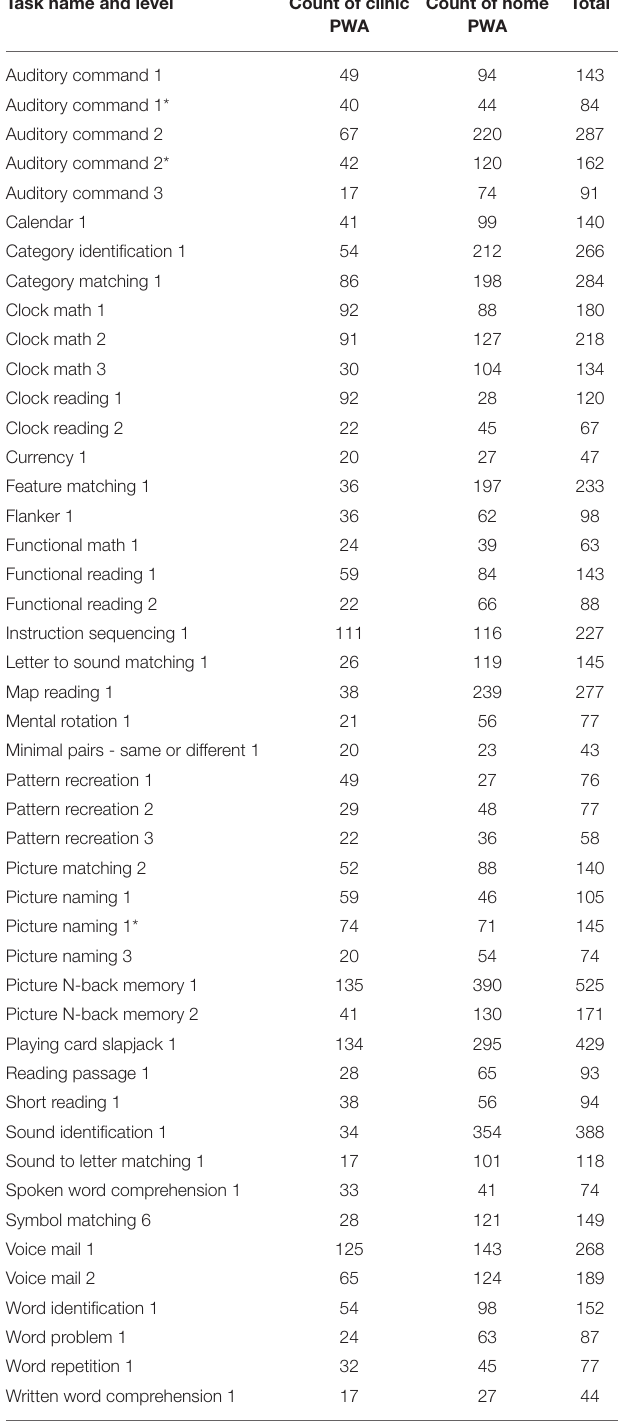
TABLE 1 | Count of PWA in age and years since injury bins, by home and clinic therapy use.